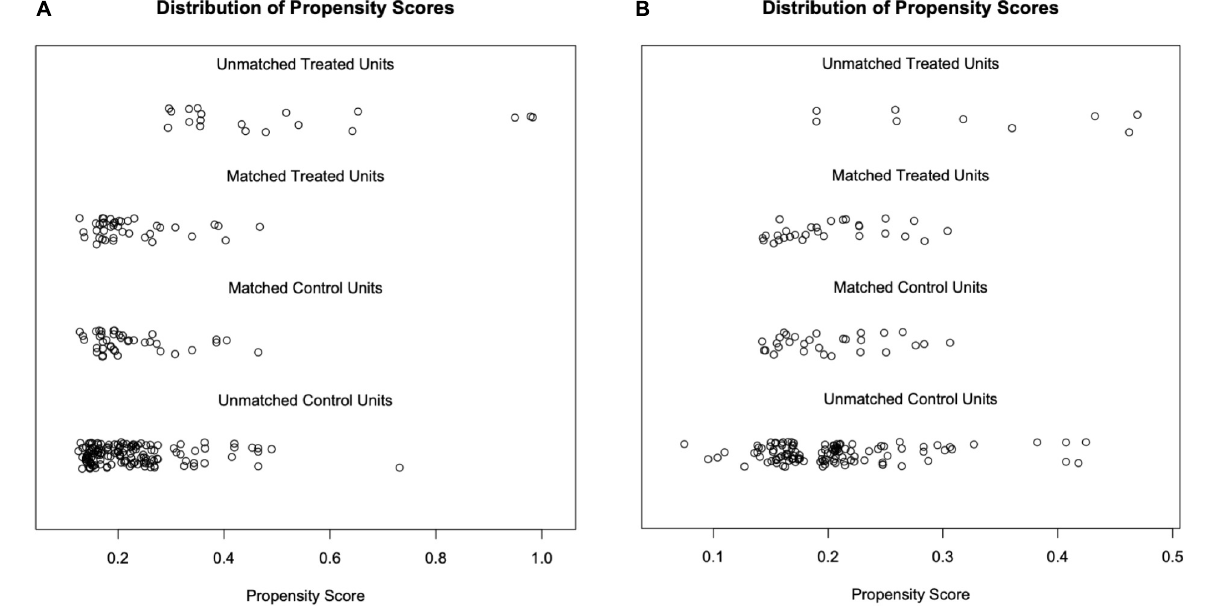
Frontiers in Medicine |